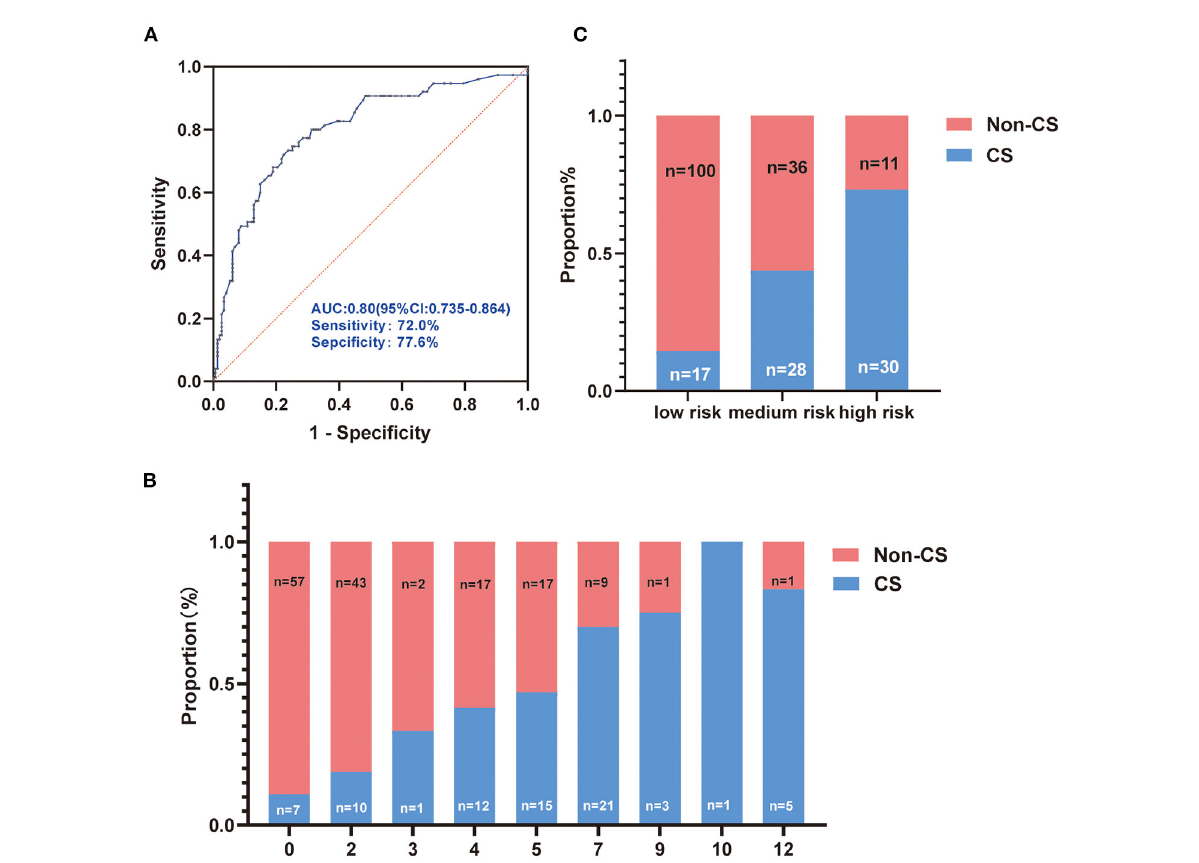
FIGURE1 Evaluation of the score system. (A) Receiver operating characteristic of the score system for predicting cryptogenic stroke (CS); (B) The proportion of CS and no-CS patients according to the score system; (C) The score system was divided into low, medium, and high-risk grades based on the proportion of 0–25%, 25–50%, and